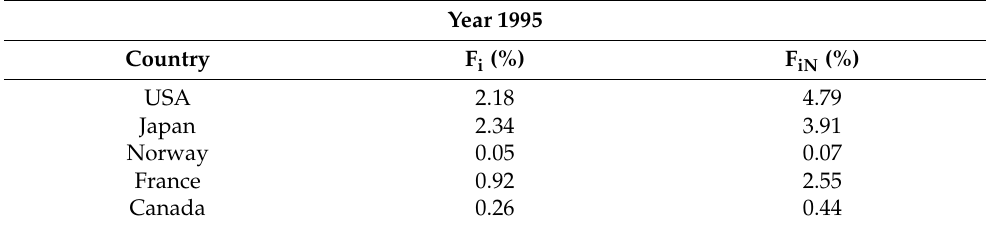
Table 11. Sagar results vs. results with CE 2 N. Own